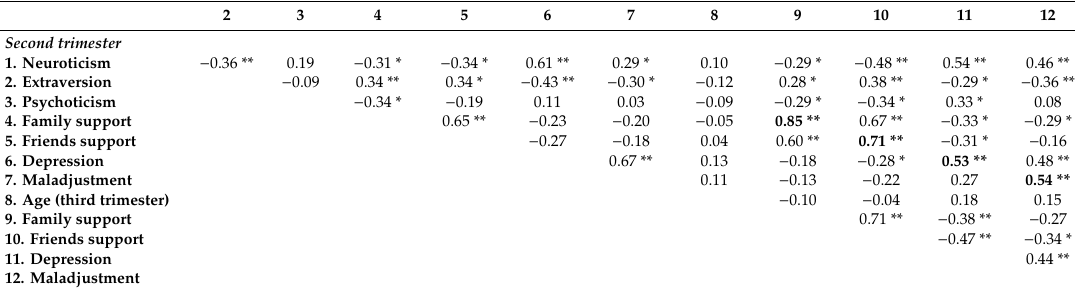
Table 4. Correlations between personality, age, and outcomes (i.e., depressive symptoms, adjustment, and social support). Second trimester 1. Neuroticism − 0.36